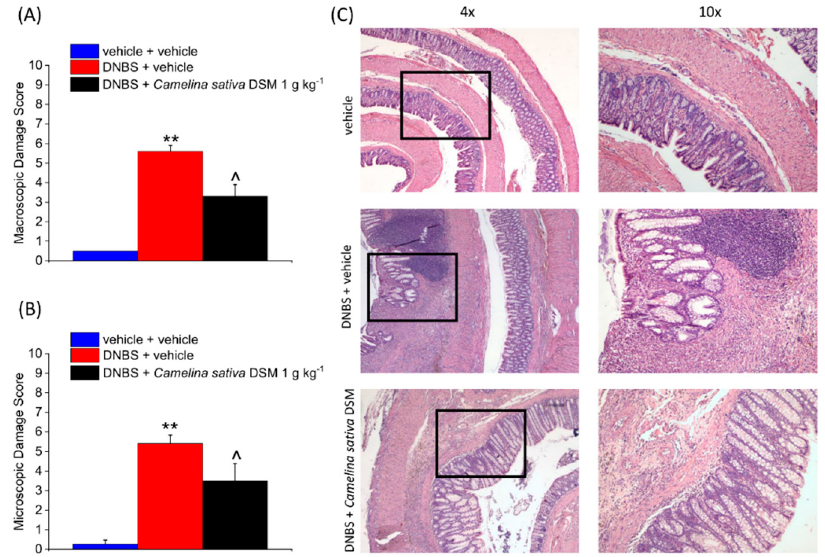
Figure 6. The effects of the repeated treatment with Camelina sativa DSM on colon damage induced by DNBS in rats. Camelina sativa DSM (1 g kg − 1 ) was administered once daily in the DNBS-treated animals, starting from the day of DNBS injection for 14 consecutive days; then tissues were collected (Day 15). The column graphs report the colon macroscopic ( A ) and microscopic ( B ) damage score; Representative pictures of haematoxylin–eosin-stained sections of full-thickness colon ( C ). Original magnification: 4× and 10×. Each value represents the mean ± SEM of six animals per group. ** p < 0.01 vs. vehicle. ^ p < 0.05 vs. DNBS + vehicle.